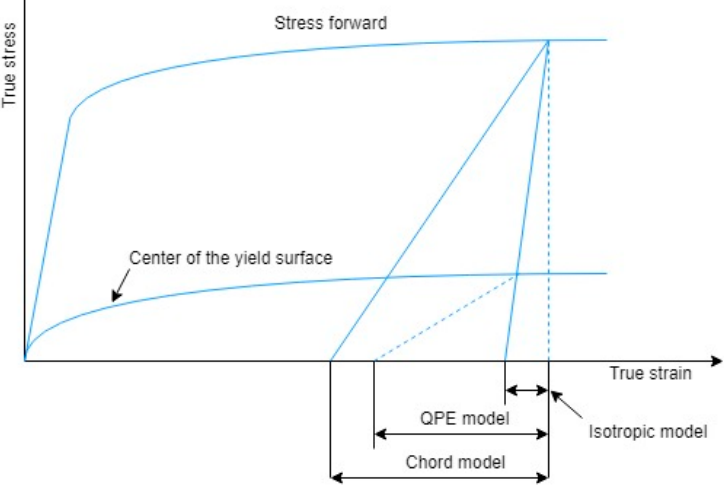
Figure 4. Strain recovery or springback in different models.